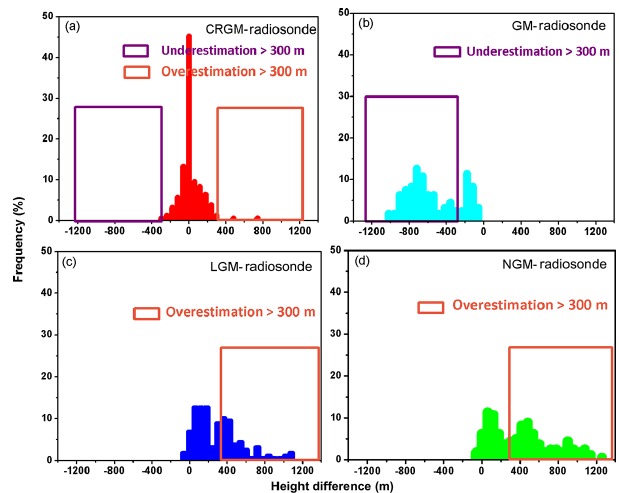
Figure 5. Histograms of the differences in BLH detected by ra- diosonde and by CRGM, NGM, LGM, and GM. The x axis is the height difference (m) between the retrieved BLH and that from ra- diosonde, and the y axis is the frequency of occurrence (%). The orange and purple regions highlight height differences of more than ±